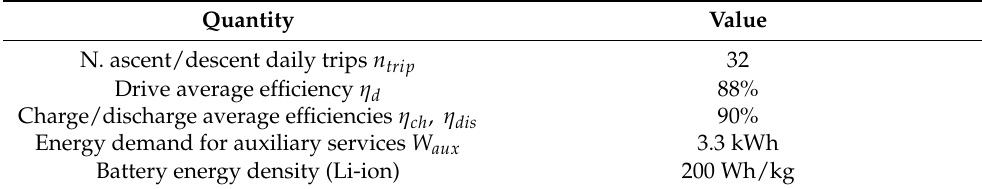
Table 8. Data for the energy source